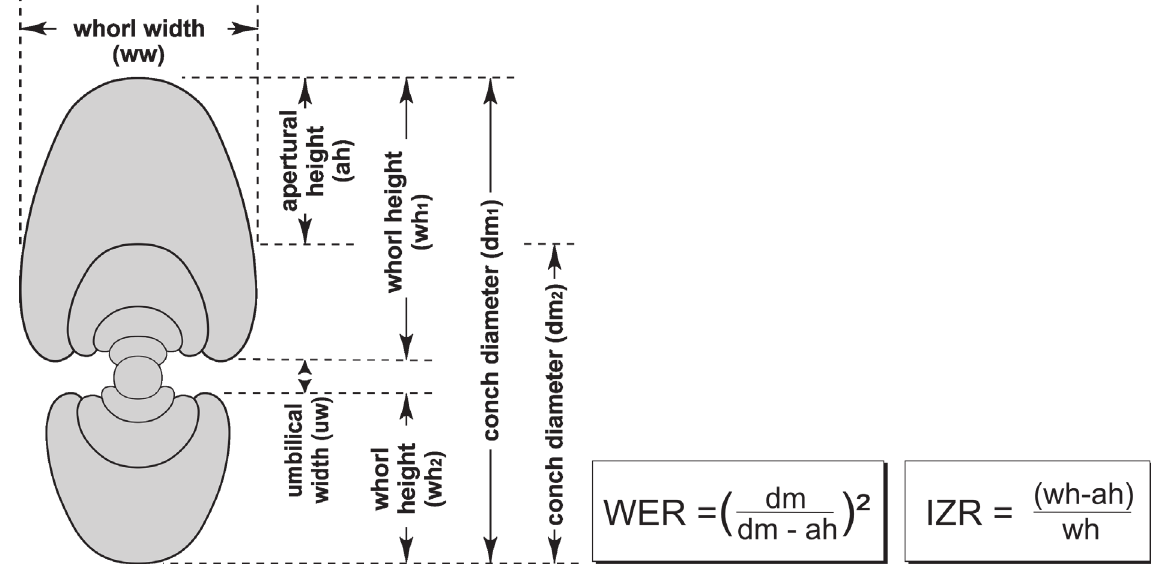
Fig. 3. The morphological terms used in the description of the ammonoid